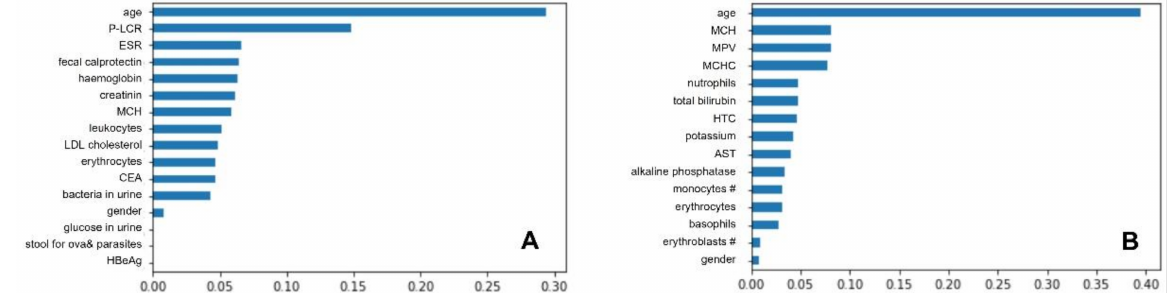
Figure 3. Random forests features of importance for ulcerative colitis ( A ) and Crohn’s disease ( B ). Abbreviations for ( A ): P-LCR, Platelet larger cell ratio; ESR, erythrocyte sedimentation rate; HGB, haemoglobin, MCH, mean corpuscular haemoglobin; LDL, low density lipoprotein; CEA, carcinoembryonic antigen; HBe Ag, Hepatitis B e Antigen; Abbrevia- tions ( B ): MCH, mean corpuscular haemoglobin, MPV, mean platelet volume, MCHC, mean corpuscular haemoglobin concentration, HCT, hematocrit, AST, aspartate aminotransferase, AP, alkaline